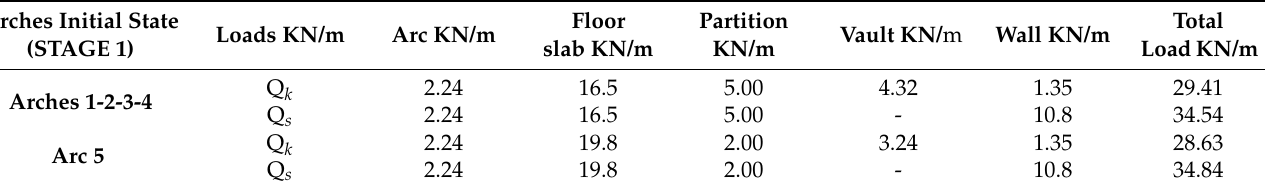
Figure 10. Initial state force diagram ( a ): arcs 1, 2, 3, and 4; ( b ) arc 5. Table 1. State of loads in the initial